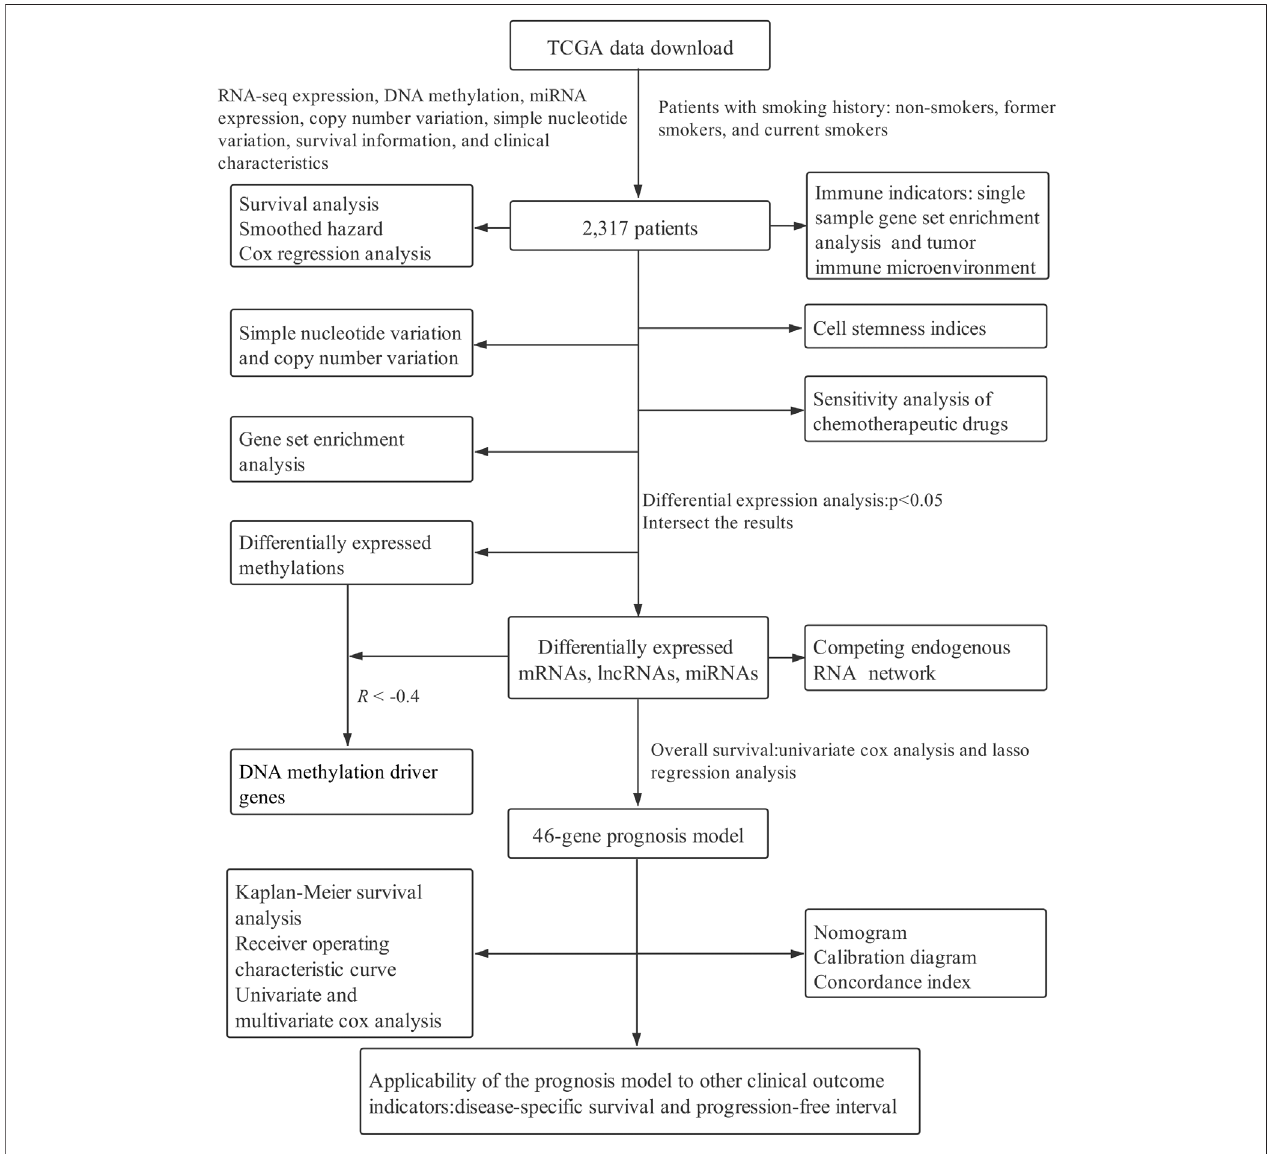
FIGURE 1 | The process of this